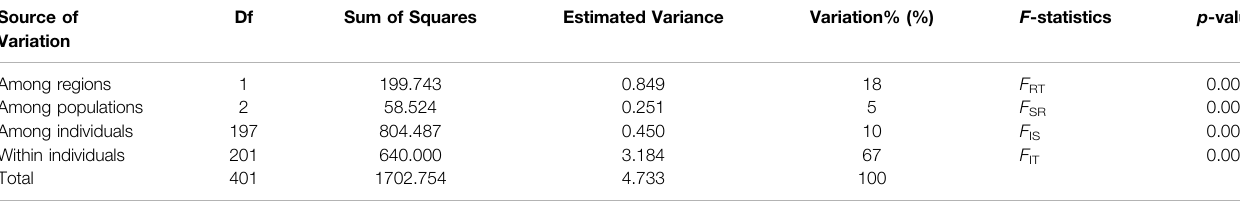
TABLE 2 | Hierarchical analysis (AMOVA) of the genetic variation in the Ae. aegypti samples collected from different sites in Sudan. Source of Df Sum of Squares Estimated Variance Variation% (%) Variation Among